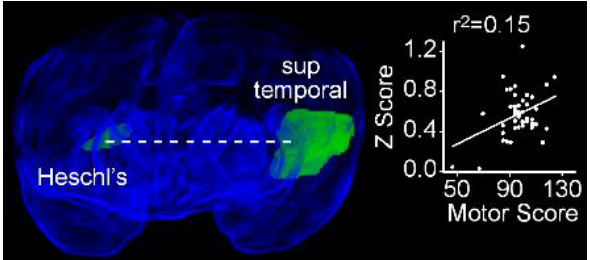
Figure 9. Resting state functional connectivity between the left superior temporal gyrus and contralateral Heschl’s gyrus exhibits a positive linear relationship with performance on the motor subscale of the Bayley III. Obliquely projected 3D reconstruction of MRI images of cerebral grey matter and identified parcellated regions derived from a neonatal atlas. Dashed white line depicts the connectivity relationship . Inset: Individual Fisher-transformed Z-scores of correlation coefficients between regions.